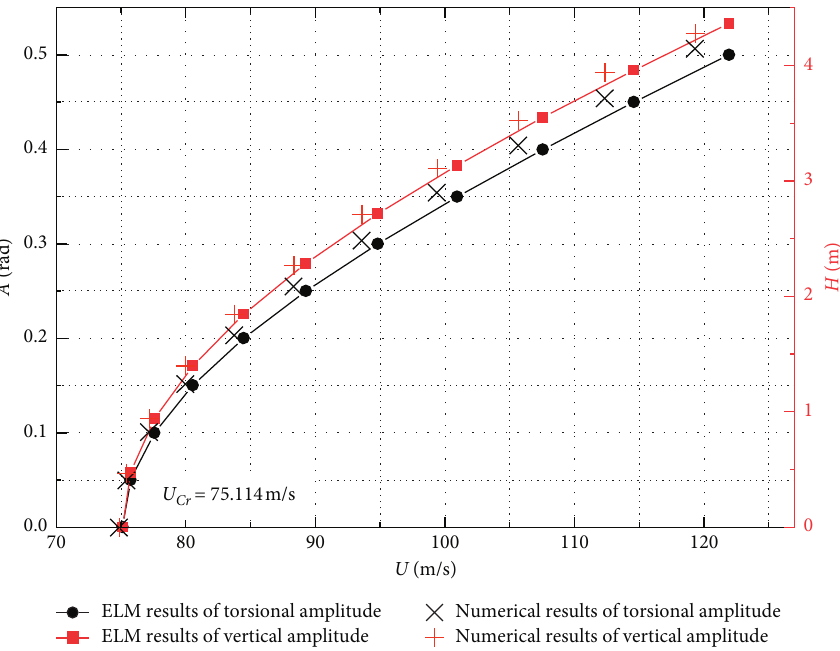
Figure 5: Curve of wind speed and amplitudes of